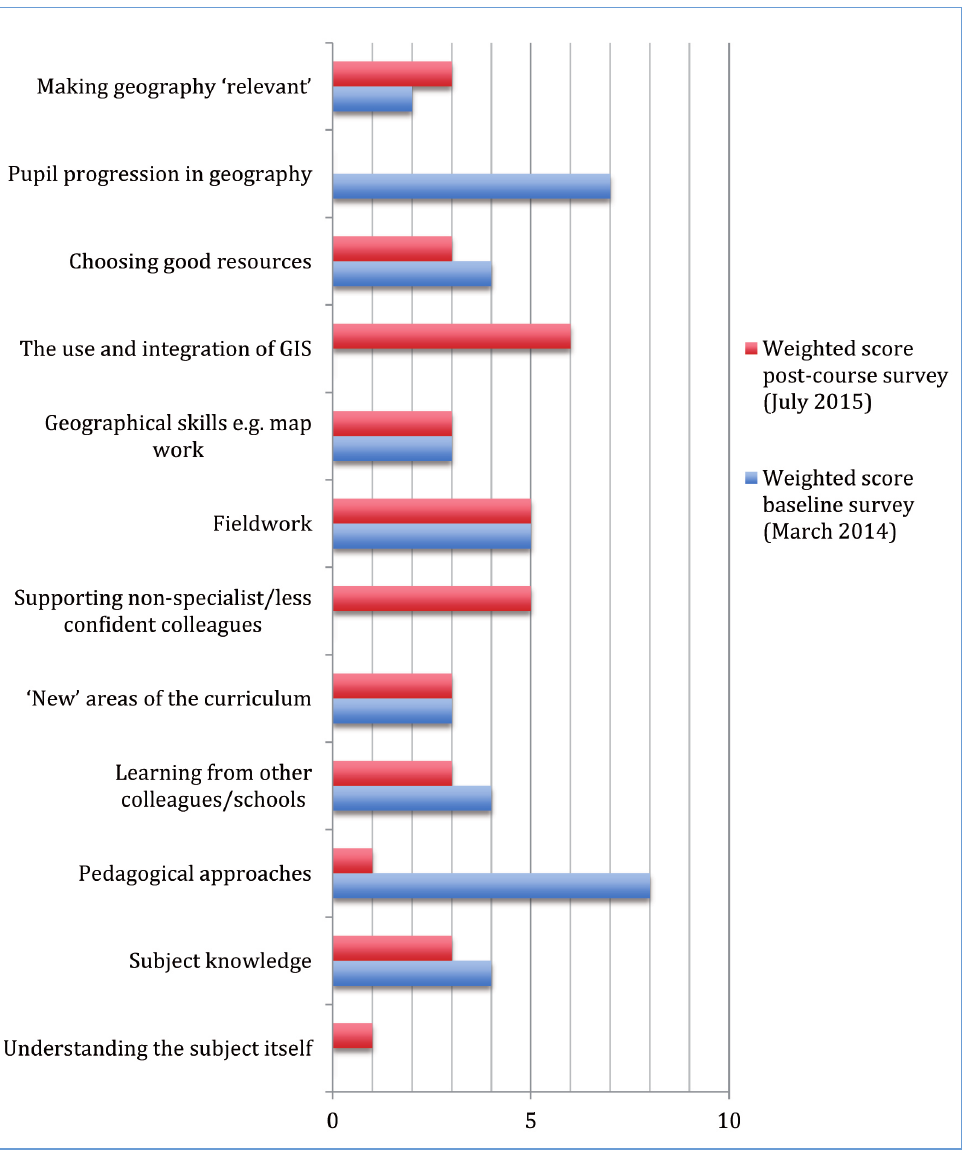
Figure 1: Supportforaspectsofgeographyteaching(primary).